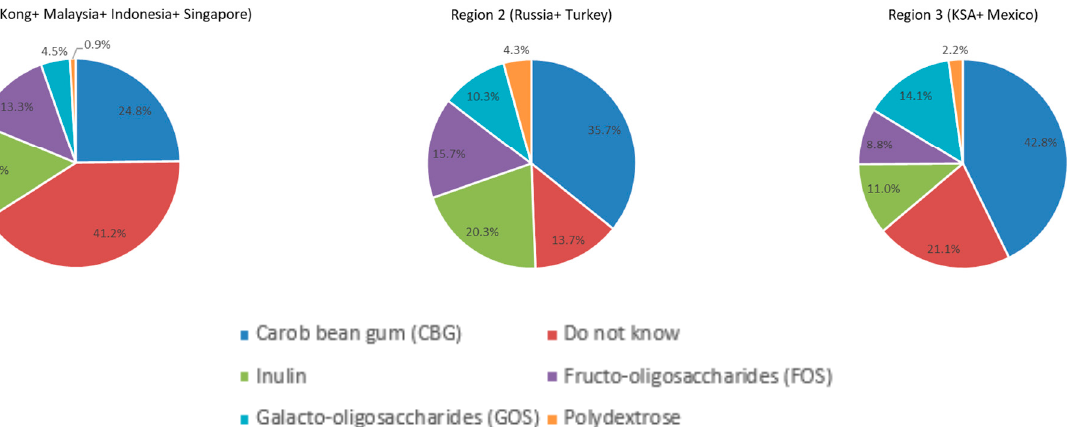
Figure 5. The most effective fiber reported for the management of FC by HCPs by region. (% of total number of respondents.).